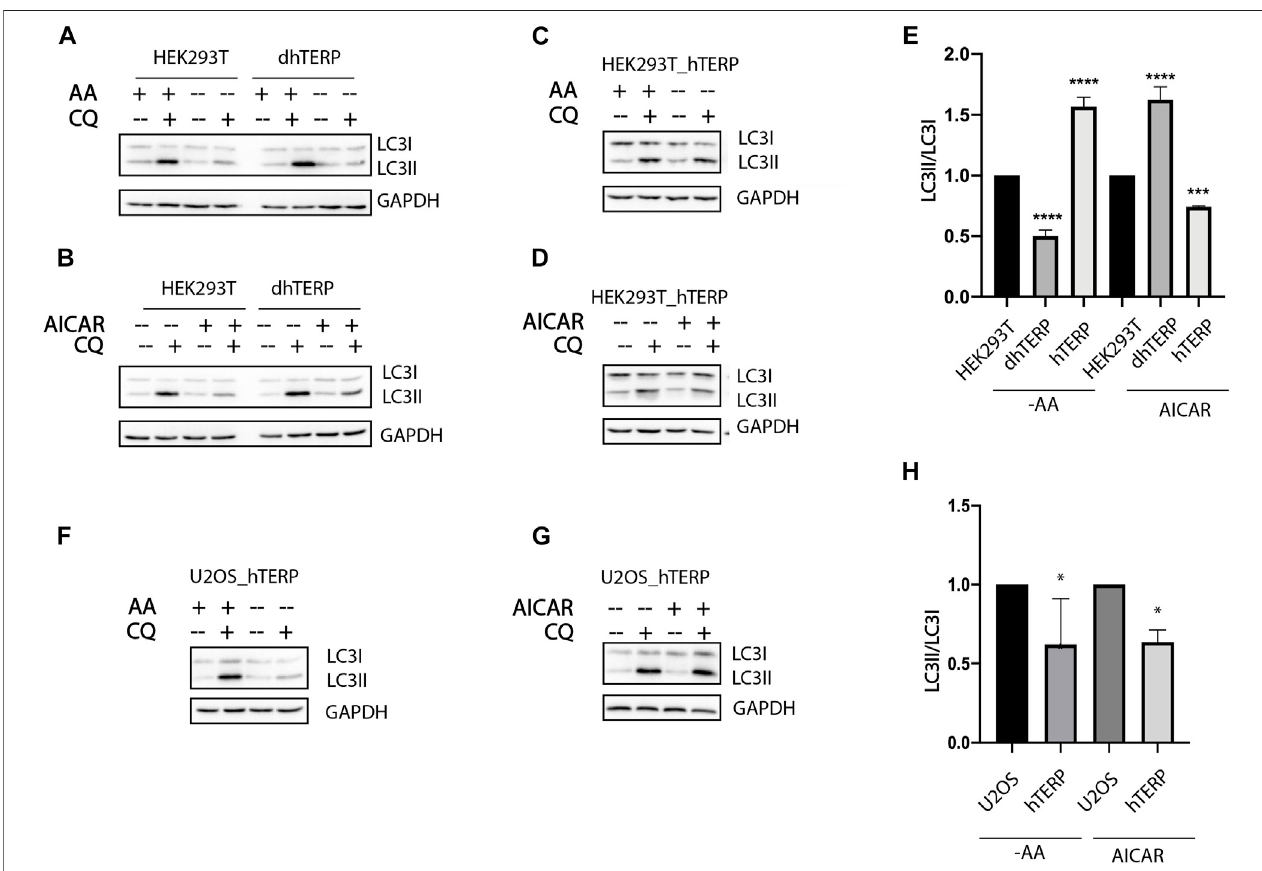
FIGURE 2 | hTERP-de fi ciency in fl uences autophagy progression. ( A,B ) Immunoblotting of lysates from wild-type and dhTERP HEK293T cells for LC3 under normal conditions (AA+) and during amino acids starvation (AA − ) (A) and under normal conditions and AICAR treatment (B) . To block autophagy progression, cells were treated with 10 µM chloroquine (CQ). GAPDH was used as loading control. ( C,D ) Immunoblotting of lysates from wild-type and overexpressing-hTERP-3HA HEK293T cells for LC3 under normal conditions (AA+) and during amino acids starvation (AA − ) (C) and under normal conditions and AICAR treatment (D) . (E) Quanti fi cation of the conversion rate of LC3-I to LC3-II in wild type, dhTERP and overexpressing hTERP HEK293T cells starved of amino acids or treated with AICAR. The ratio of LC3-II to LC3-I in chloroquine treated amino acids starved cells (A,C) or cells under AICAR treatment (B,D) was normalized to the ratio of LC3-II to LC3-I in chloroquine treated cells cultivated in normal conditions. Conversion rate of LC3 for mutant cells was normalized to the same ratio for wild type cells. The conversion rate of LC3-I to LC3-II was determined from three independent experiments (mean ± SEM) and quanti fi ed using GraphPad Software. *** p < 0,001 by Dunett ’ s multiple comparison test. (F,G) Immunoblotting of lysates from wild-type and overexpressing hTERP-3HA U2OS cells for LC3 under normal conditions (AA+) and during amino-acids starvation (AA − ) (F) and under normal conditions or AICAR treatment (G) . (H) Quanti fi cation of the conversion rate of LC3-I to LC3-II in wild type and overexpressing hTERP U2OS cells starved of amino acids or treated with AICAR. The ratio of LC3-II to LC3-I in chloroquine treated amino acids starved cells (F) or cells under AICAR treatment (G) was normalized to the ratio of LC3-II to LC3-I in chloroquine treated cells cultivated in normal conditions. Conversion rate of LC3 for mutant cells was normalized to the same ratio for wild type cells. The conversion rate of LC3-I to LC3-II was determined from three independent experiments (mean ± SEM) and quanti fi ed using GraphPad Software. ** p < 0.01 and * p < 0,05 by Dunett ’ s multiple comparison